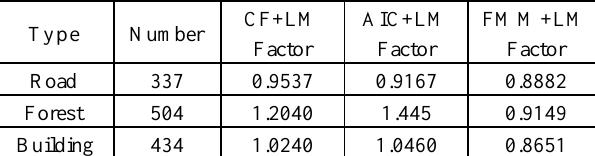
Figure 4. Waveform (measured data) decomposition results based on three different methods